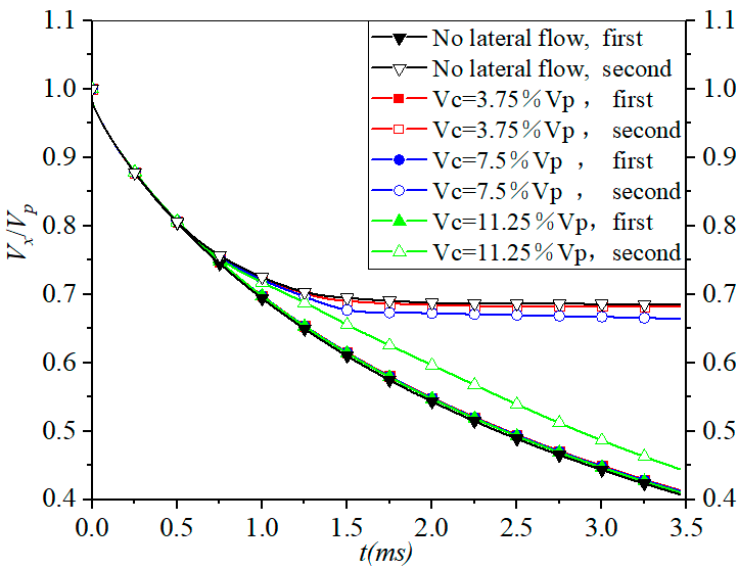
Figure 18. The change in the velocity in the x-direction with the time under different conditions.